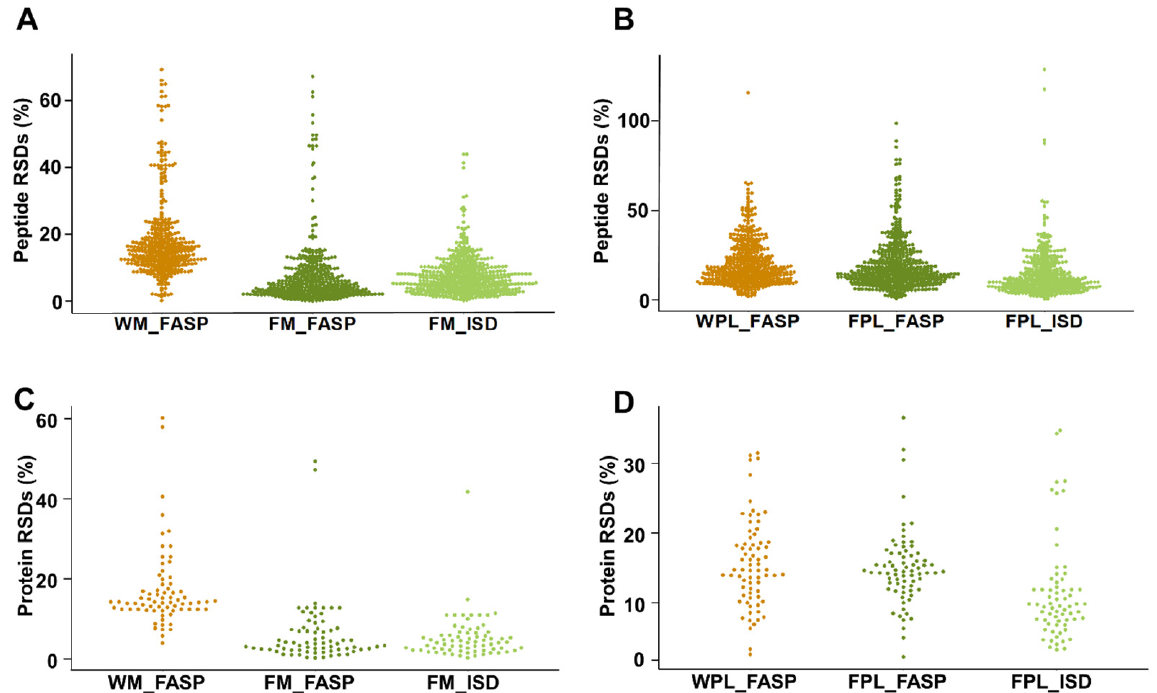
Figure 5. Relative standard deviations (RSDs) for quantifiable peptides in ( A ) human milk and ( B ) plasma, as well as RSDs for the proteins calculated based on the peptide peak area sum for the different sample preparation methods applied to ( C ) human milk and ( D ) plasma. Experiments were performed in three independent replicates.